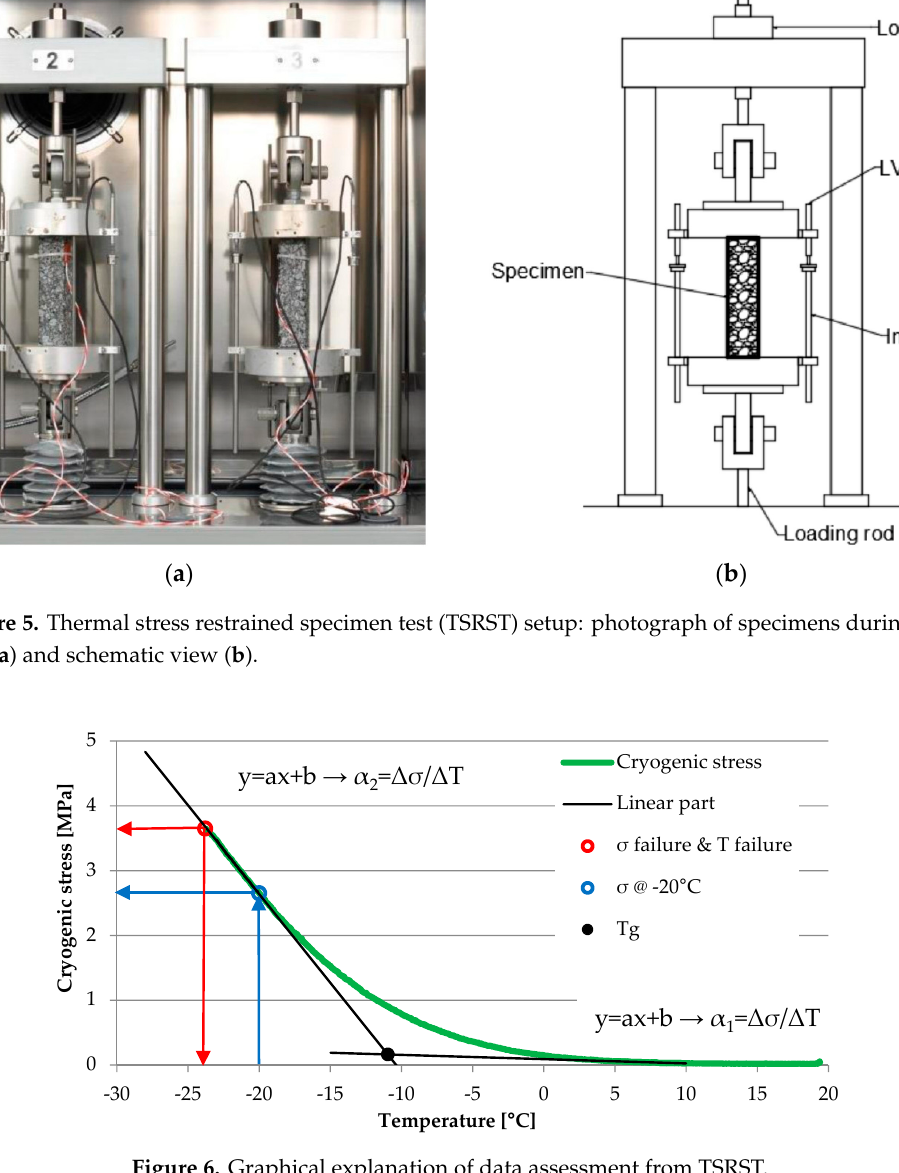
Figure 6. Graphical explanation of data assessment from TSRST.